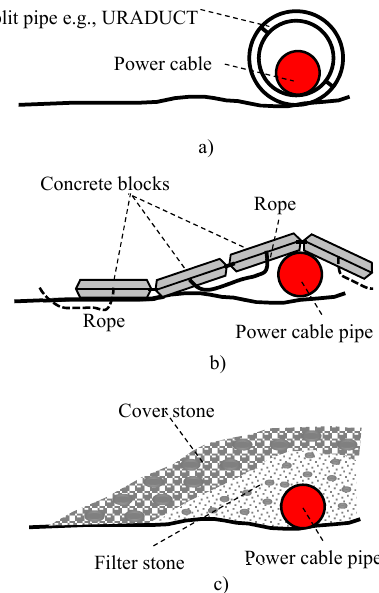
Figure 4. Protection of cable through burial: ( a ) jetting and fluidification; ( b ) ploughing; ( c ) mechanical cutting; ( d ) open-trench dredging.